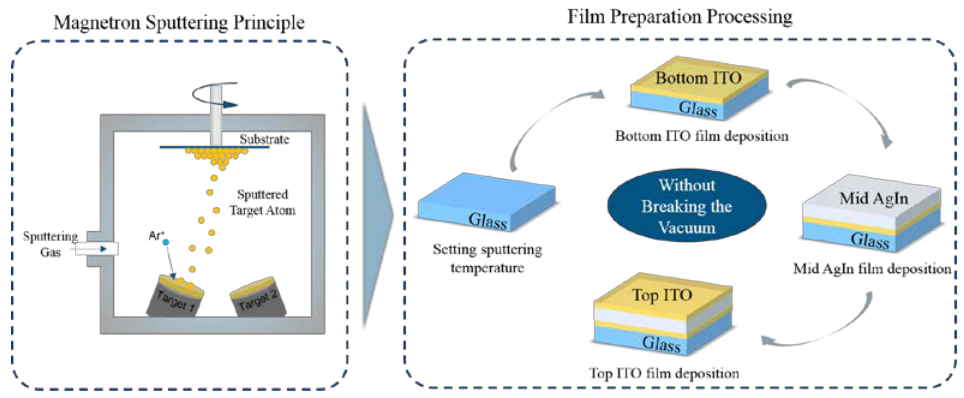
Figure 1. Scheme of ITO/AgIn/ITO multilayer film preparation principle and processing. The thickness of the ITO/AgIn/ITO multilayer films was measured with a step profiler. The crystal structure was determined using an X - ray diffractometer with Cu Kα radiation (λ = 1.5412 Å). The surface microstructure and cross - sectional observations of the multilayer films were characterized by field emission scanning electron microscopy (SEM). Surface roughness and surface morphology were estimated by atomic force microscopy (AFM). The electrical properties of the samples were measured using the van der Pauw method in a Hall effect measurement system. The sample was a square of approximately 10 × 10 mm 2 . For testing, the four contacts of the sample stage were pressed on the four corners of the sample at a distance of about 8.5 mm and then put into the tester for measurement . The contact distance could be adjusted according to the size of the sample. The applied test current was set to 10 µ A. The test results were averaged over several measurements.